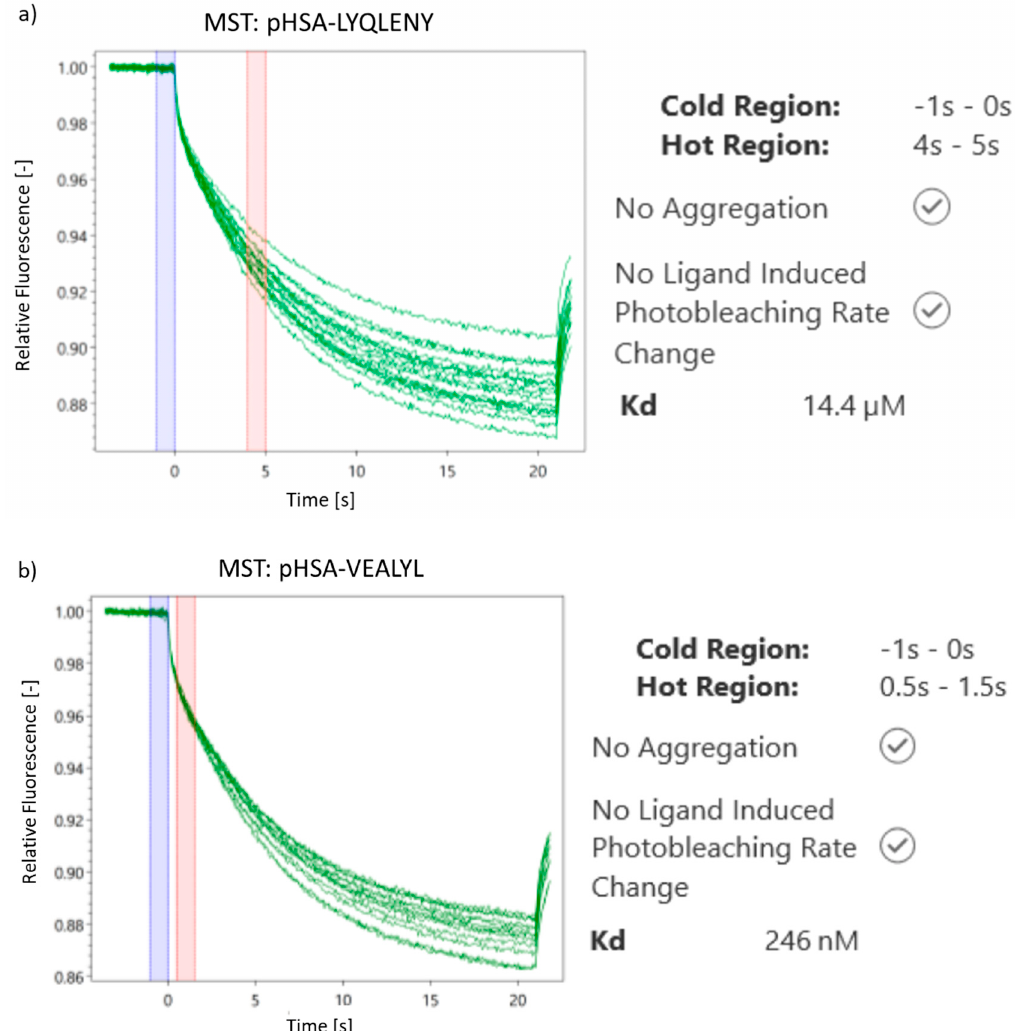
Figure 10. MST spectra recorded for: ( a ) complex of H-LYQLEN-OH ( 5 ) with HSA, ( b ) H-VEALYL-OH ( 6 ) with HSA.